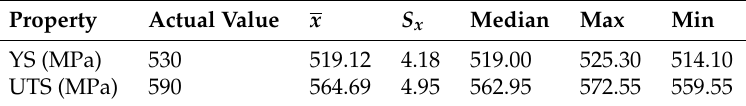
Table 7. Statistical metrics about the predictive iterations of the ANN.